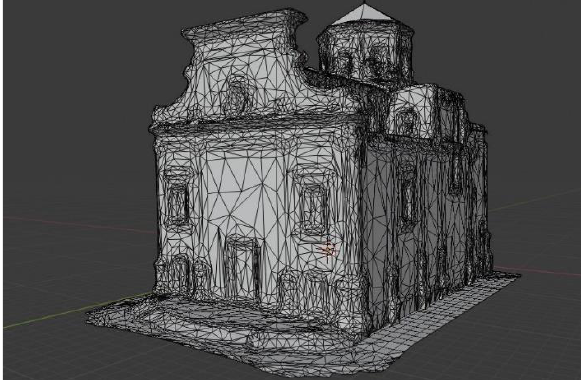
Figure 6. The geometric mesh model of the church obtained following the first solution after editing operation in Blender.